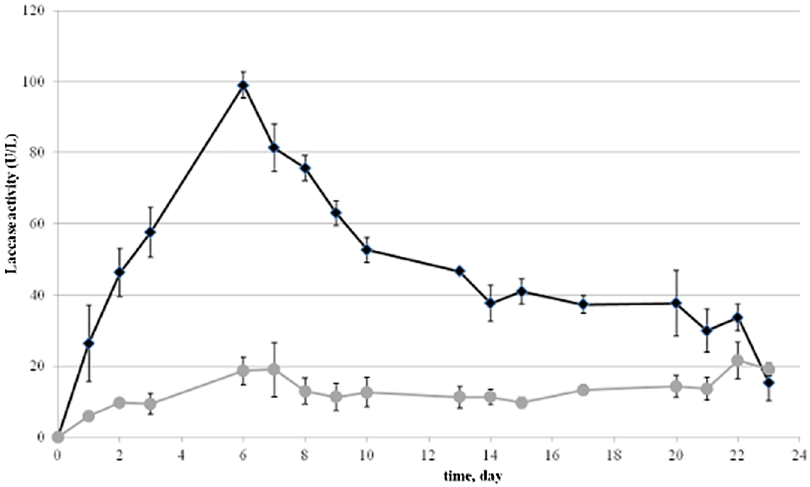
Fig 4. Laccase activity in the repeated cycles of EDCs degradation by T . versicolor in WM. Comparison of laccase activity in WM (grey circles) and EDCs supplemented WM (black diamonds).